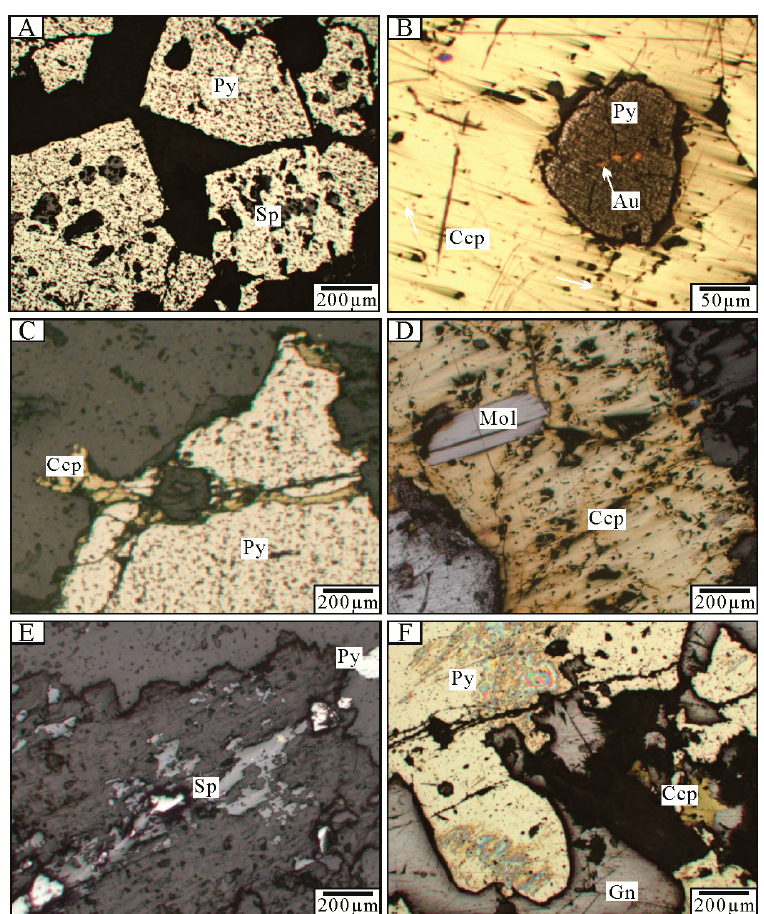
Figure 5. Photomicrographs of key mineral assemblages in the Jinchang deposit. ( A ) Subhedral pyrite replaced by sphalerite; ( B ) native gold in pyrite; ( C ) pyrite cross-cut by chalcopyrite; ( D ) chalcopyrite–molybdenite assemblage; ( E ) pyrite–sphalerite veinlet; ( F ) pyrite–chalcopyrite–galena assemblage. Abbreviations: Py, pyrite; Ccp, chalcopyrite; Gn, galena; Sp, sphalerite; Mol, molybdenite; Au, gold.